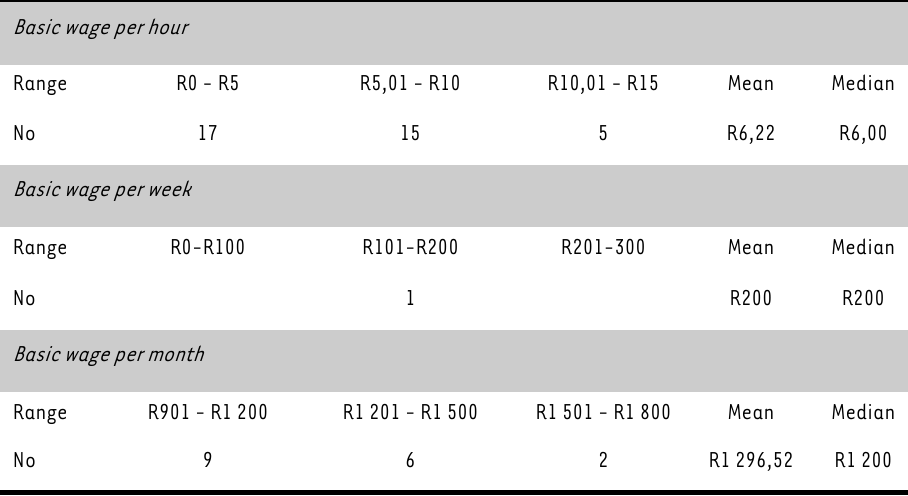
TABLE 2: Basic wages (excluding commission and tips) per hour, week or month, 2008